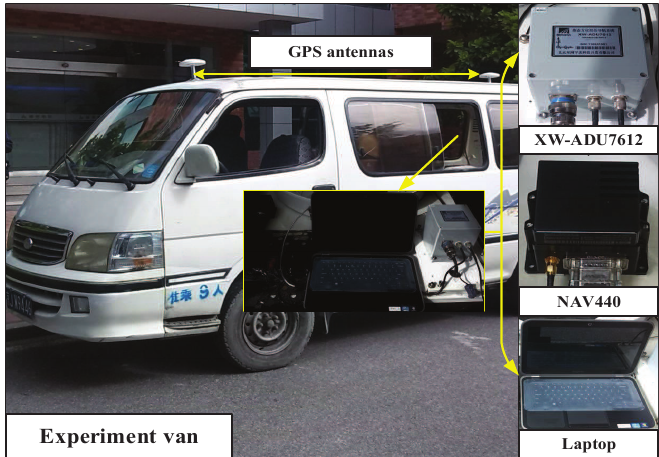
Figure 12. Configurations of the van